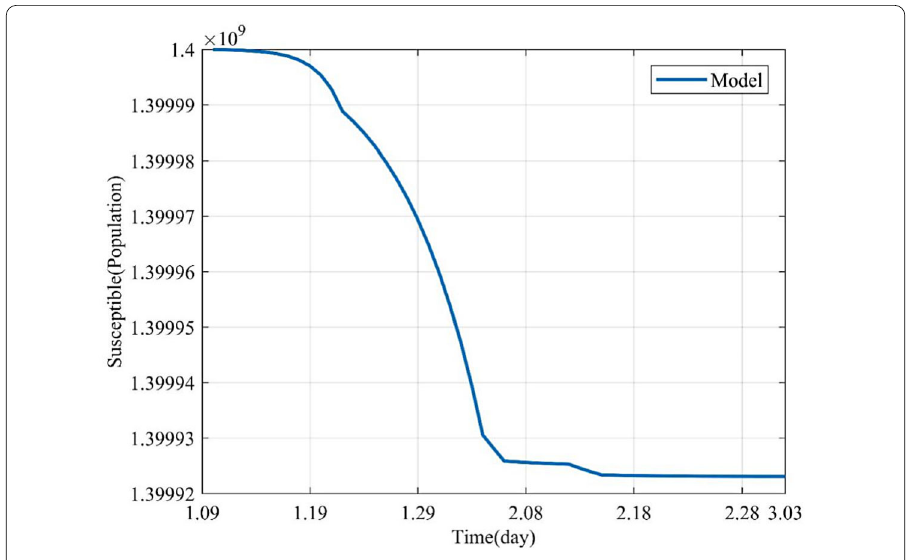
Figure 2 Dynamic trends of the susceptible